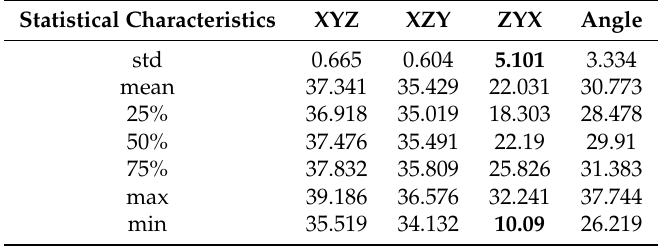
Table 3. Statistical data evaluation for Nominal Stress for each orientation